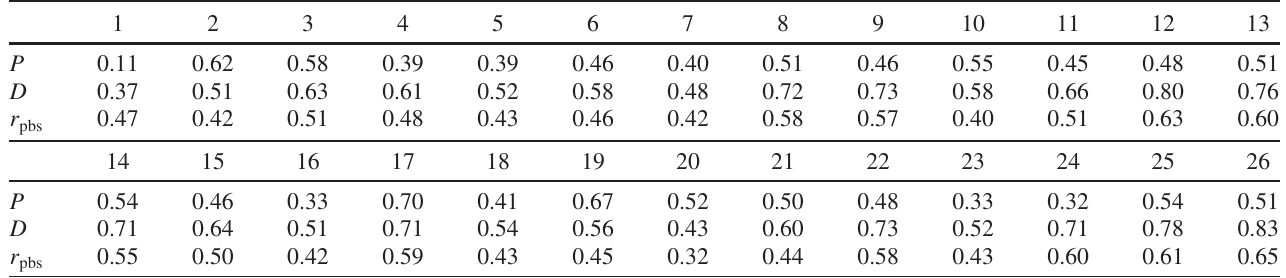
) for each of the 26 items of the modified pbs